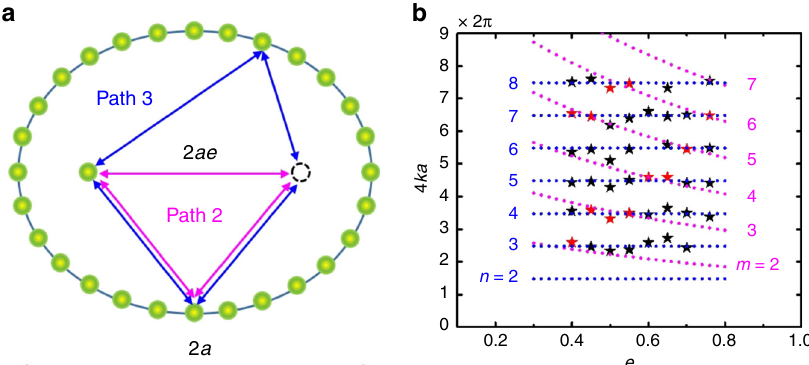
Fig. 3 Schematics of the quantum interference model and the quantization conditions. a Sketch of an EQC with different scattering paths. b Comparison of the experimentally determined peak positions (red stars are the central peaks and the black stars are the rest peaks) and the theoretically obtained quantized conditions. Blue dotted lines marked by n are the condition corresponding to Path 3 (blue quadrangle in a ) described in Eq. (3), and magenta dotted curves marked by m are the conditions corresponding Path 2 (magenta triangle in a ) described in Eq. (4).